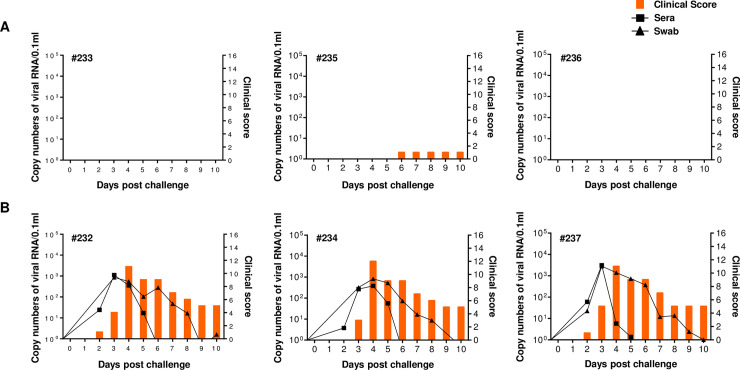
Pathogenesis of the chimeric viruses in pigs.The challenge experiment was carried out with six 90-day-old Yucatan pigs. (A) Three pigs were inoculated with pOm-AD-83K (#233, #235, #236). (B) Another three pigs were inoculated with pOm-AD-83E (#232, #234, #237). Each virus was inoculated on the footpad at a concentration of 105.0 TCID50/0.1mL. The left Y-axis of the graph shows the amount of virus in sera and swab as log10 values and the right Y-axis shows the clinical index as the maximum value of 16 points.